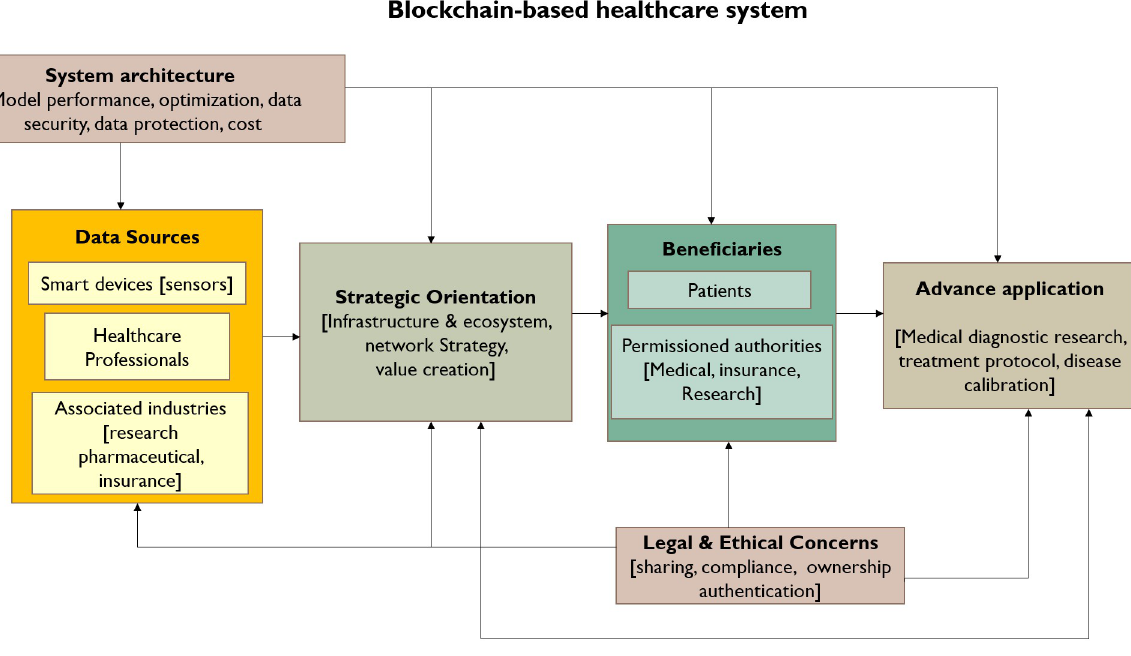
Fig 10. Research